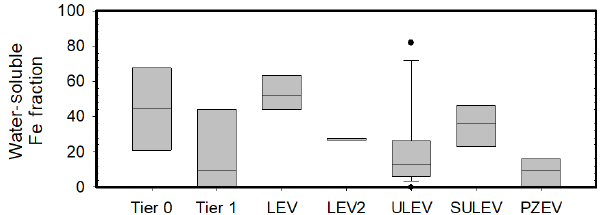
Figure 2. Water-soluble iron from the 32 vehicles tested reported in water-soluble iron fraction. The center black line represents the median value and the edges of the boxes represent the 25th and 75th percentiles, while the whiskers are the 10th and 90th